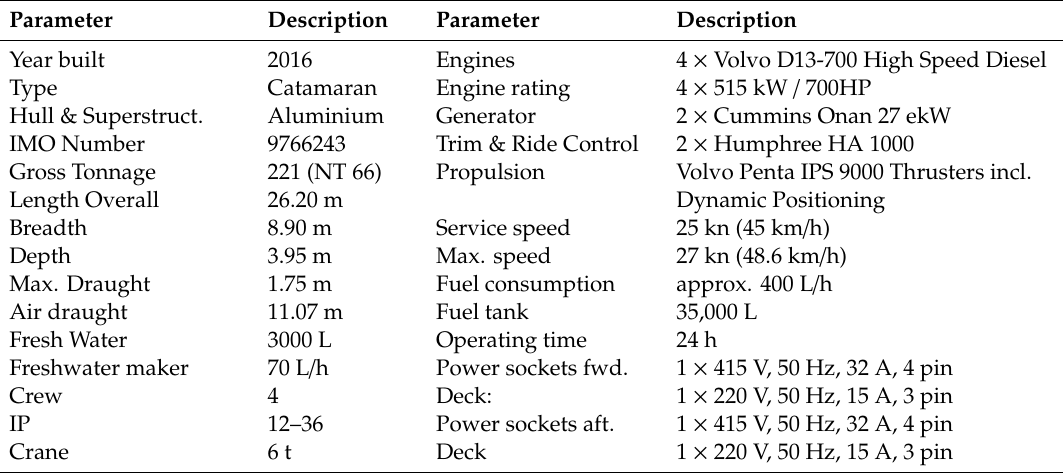
Table 1. CTV MHO Grimsby basic parameters [44].